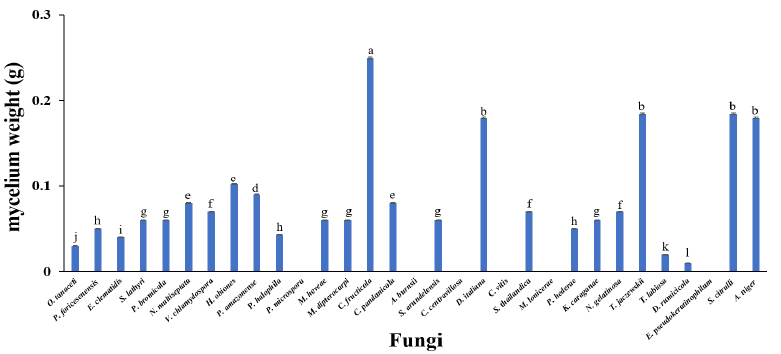
Figure 1. Mycelium dry weight of fungi cultured with LDPE film after 30 days of incubation. Different letters above the bars indicate significant differences ( p < 0.05).